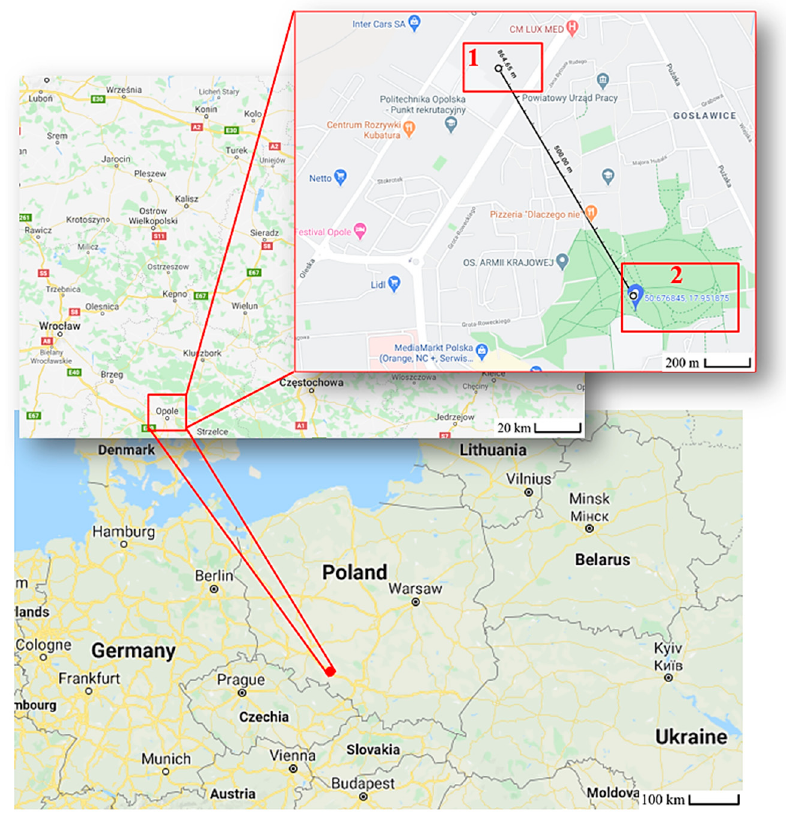
Figure 1. Location number 1 and 2 of the places where air pollutants were measured with the low-cost multisensory device mounted on an unmanned aerial vehicle (UAV).